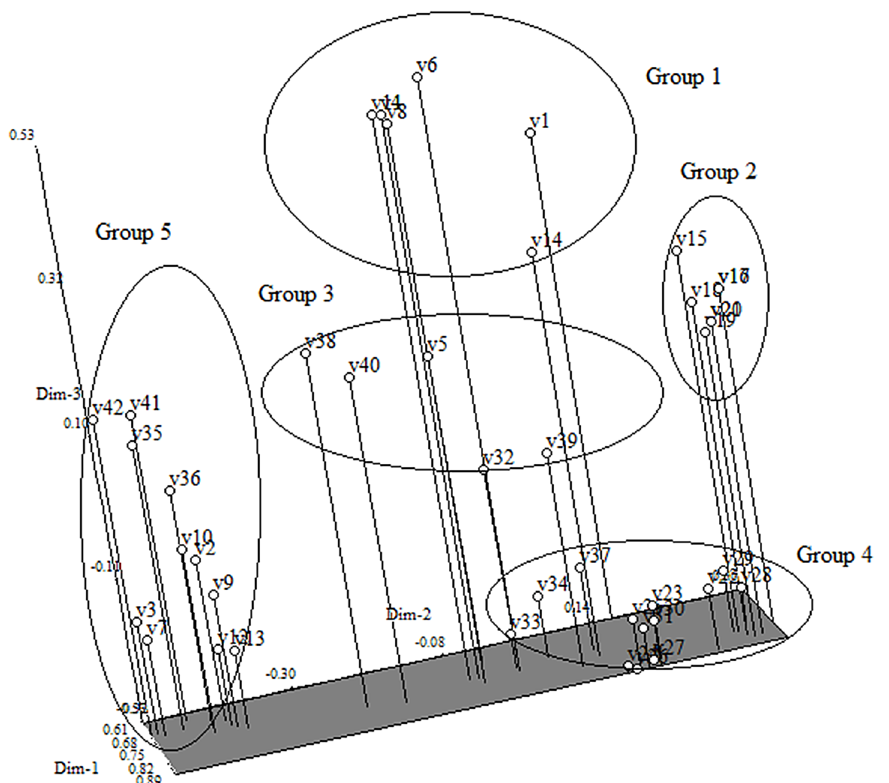
Fig 3. Principle component analysis (PCA) from SSR markers